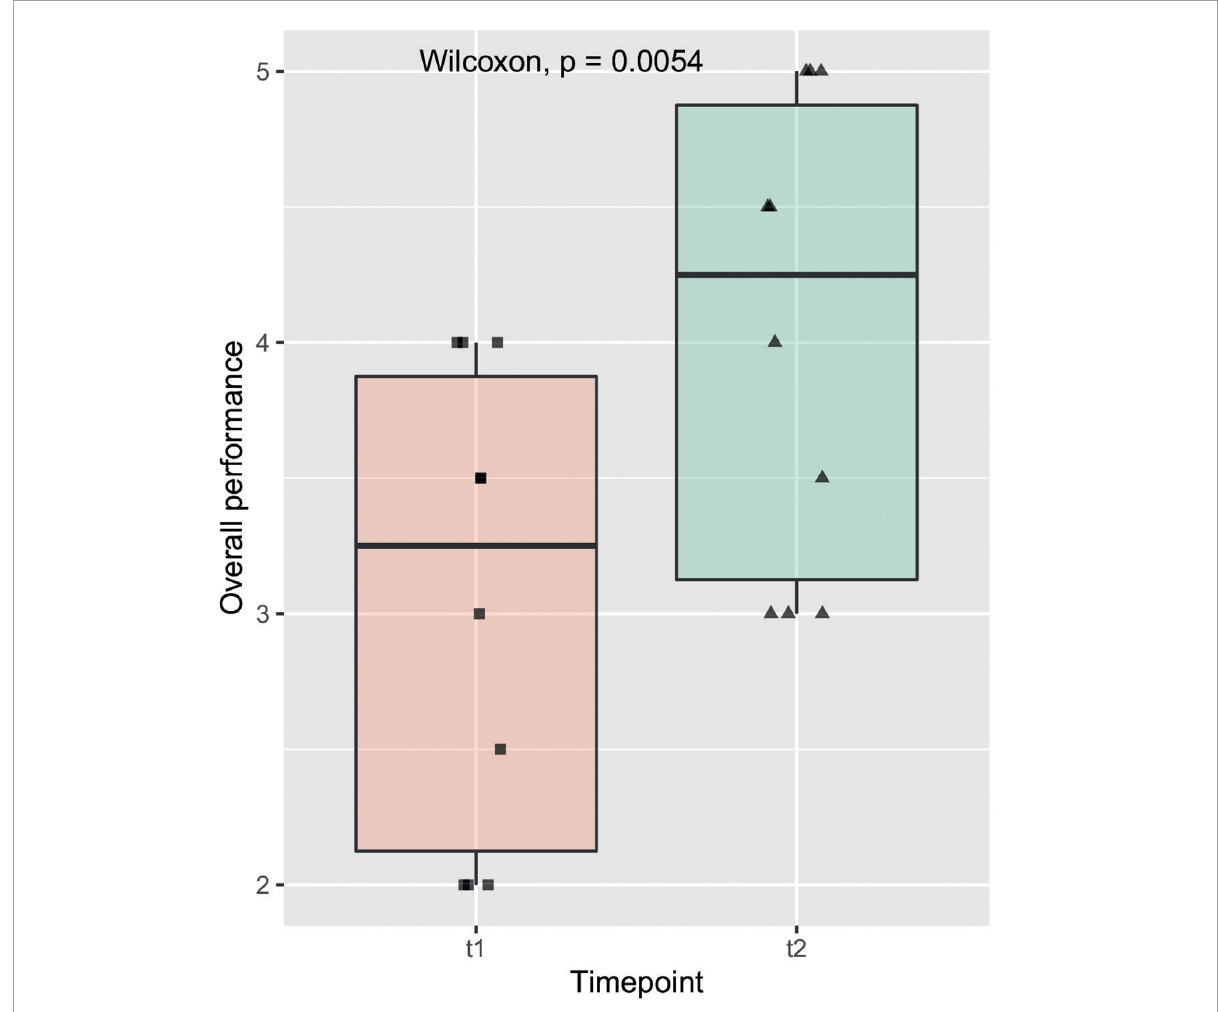
FIGURE4 Overall performance: The box plot shows the observed item overall performance on the y axis compared to the two timepoints t1 and t2 on the x axis. The solid line represents the median, the box represents the interquartile range (IQR) and the whiskers represent 1.5x IQR. Individual data points are shown on the plot with a horizontal jitter for better recognition. The result of the Wilcoxon signed rank test is featured here as well as in Table 1